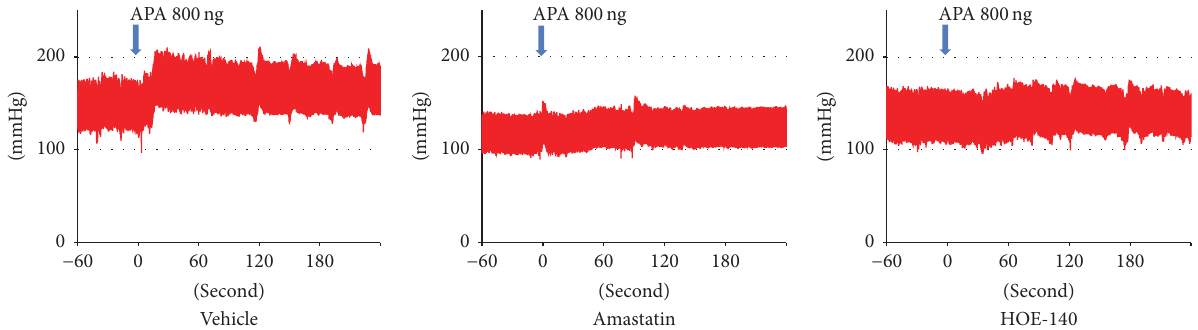
Figure 5: Representative traces of arterial pressure after intracerebroventricular (icv) administration of aminopeptidase A (APA) following pretreatment with amastatin or HOE-140. Thirty minutes prior to the icv administration of 800ng of APA, Wistar-Kyoto rats received icv administration of the following drugs: vehicle ( 𝑛 = 6 ), 800 nmol of amastatin ( 𝑛 = 6 ), or 1nmol of HOE-140 ( 𝑛 = 7 ). Icv administration of vehicle, amastatin, and HOE-140 did not change the baseline MAP. Pretreatment of amastatin and HOE-140 significantly attenuated the pressor response to APA. Arrow: time for APA